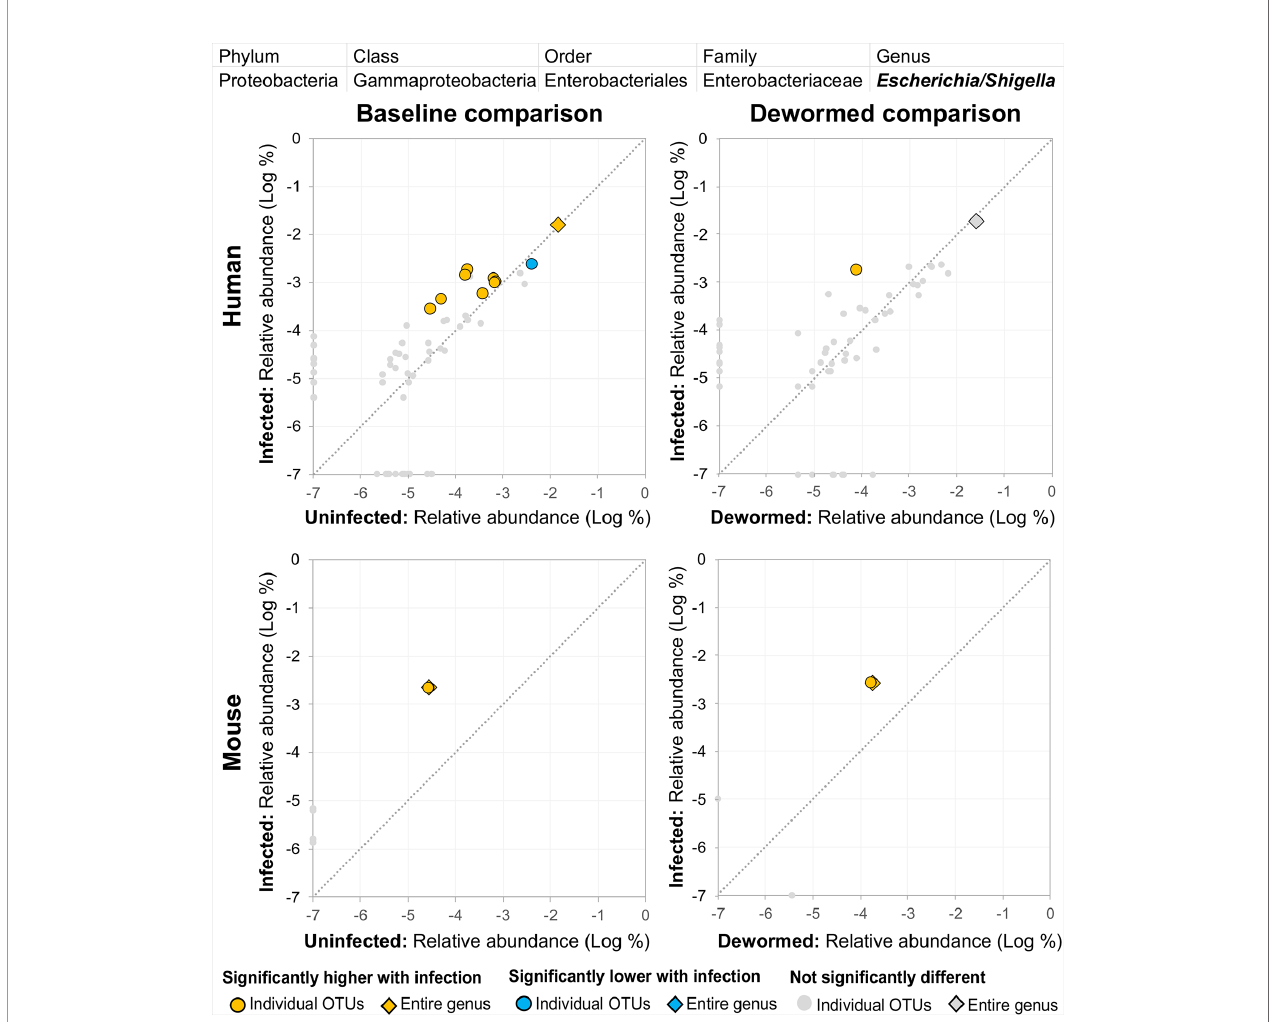
FIGURE 4 | The relative abundance (%) of all Escherichia/Shigella (genus) OTUs in each differential comparison among samples from whipworm-infected and uninfected humans and mice. Signi fi cant differentially abundant OTUs in each comparison (as identi fi ed by LEfSe) are colored in orange (higher with infection) and blue (lower with infection). The sum of all OTUs in the genus is represented with a diamond symbol. This is one of four genera with at least one OTU signi fi cantly higher in infection in all four